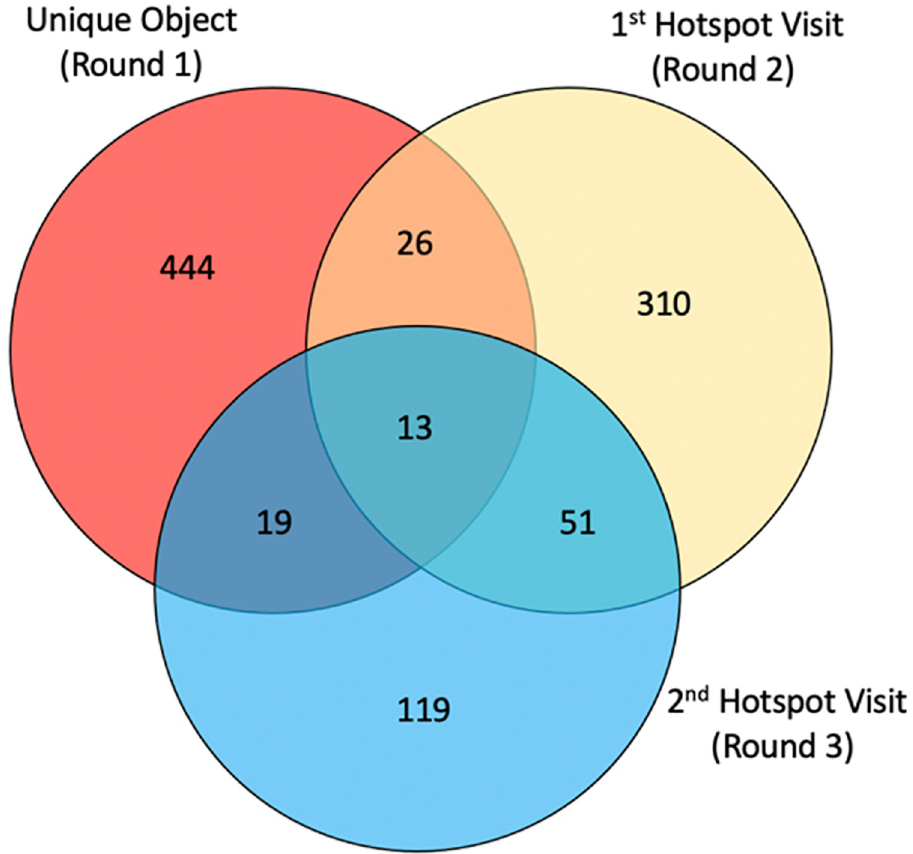
Fig 3. Venn diagram of the 3-round capture-recapture method for estimating the population size of people who inject drugs in Kabul, Afghanistan, 2019.